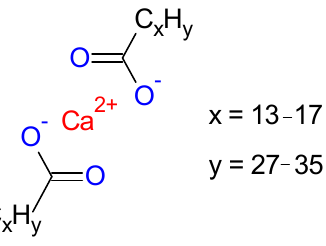
3 Table 1. Percentage of fatty acids present in the SB/PF used to synthesize the anionic surfactant. Fatty Acids (Carbon Atoms)